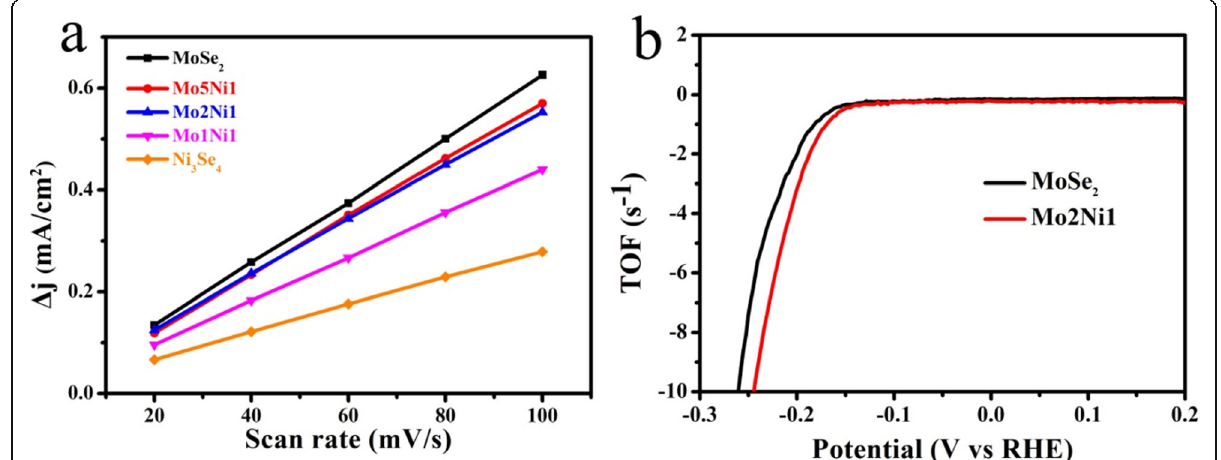
Fig. 7 a Double-layer capacity current versus scan rate of MoSe 2 , Mo5Ni1, Mo2Ni1, Mo1Ni1, and Ni 3 Se 4 samples. b Calculated TOFs of pure MoSe 2 and Mo2Ni1